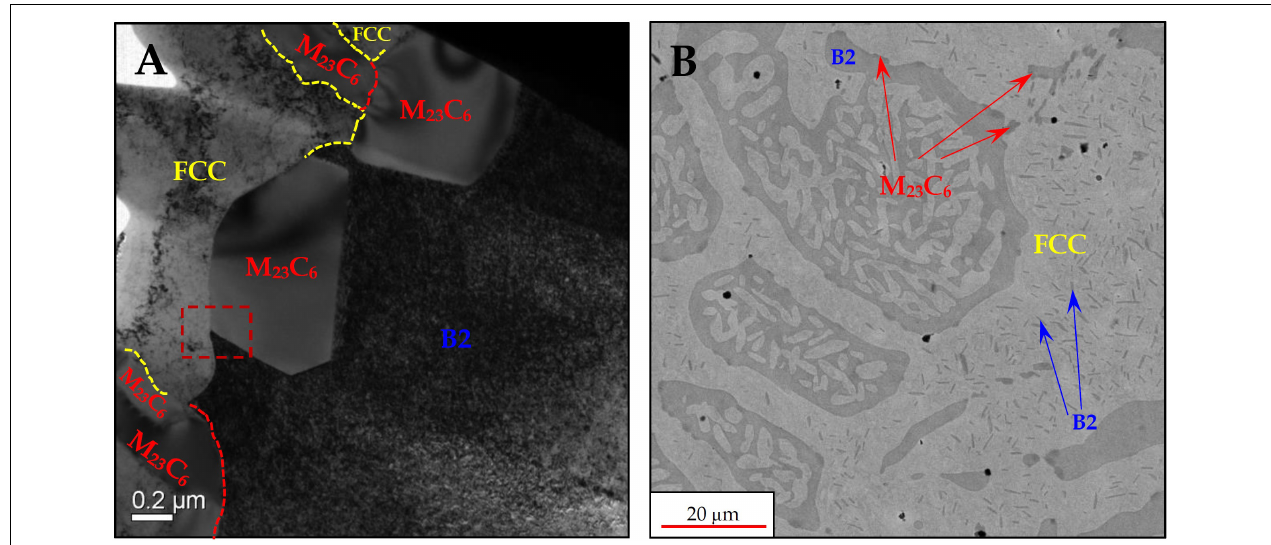
FIGURE 6 | (A) BF-TEM micrographs showing the general morphology of the phases comprising the microstructure in homogenized AlCrFe 2 Ni 2 alloy; (B) An HRSEM micrograph showing the general microstructure in homogenized AlCrFe 2 Ni 2 alloy.